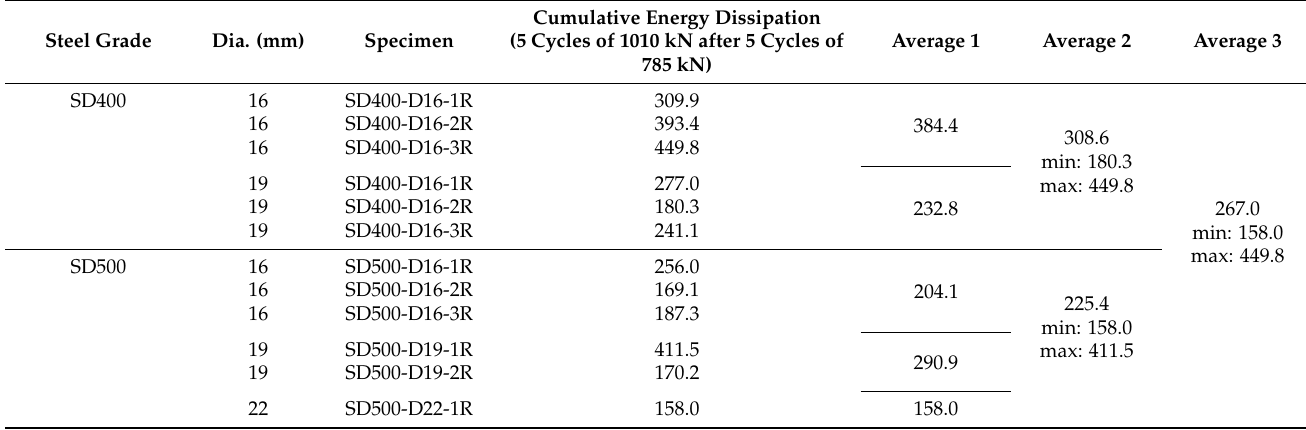
Table 14. Energy dissipation according to transverse rebar type (repeated load = 1010 kN) (unit = kN · mm). Steel Grade